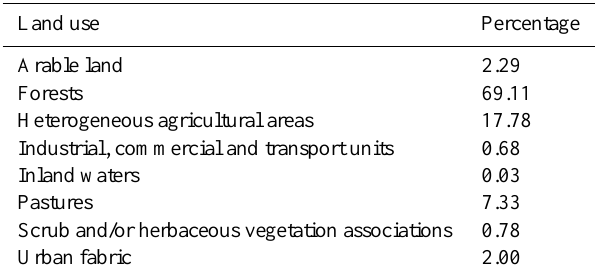
Table 1. Case study area land use according to Corine Land Cover maps of